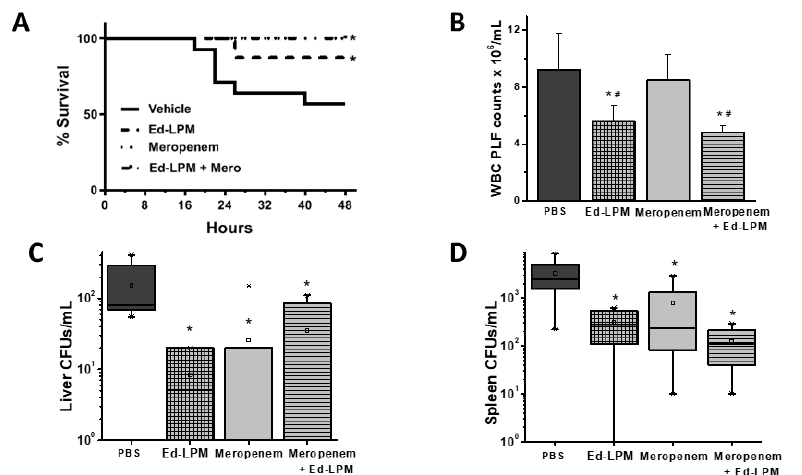
Figure 3. Effect of Ed-LPMs in antibiotic treated fecal sepsis. Mortality was significantly increased with PBS (6/14, 43%) compared to Ed-LPM therapy (1/8, 12%), Meropenem therapy (0/8, 100%), or combined Meropenem and Ed-LPM therapy (0/8, 100%) (Panel A , p = 0.021). Ed-LPM therapy—both alone and combined with Meropenem therapy—decreased peritoneal white blood cell counts (Panel B , p = 0.023); in contrast, Meropenem alone had no effect. Ed-LPM therapy, Meropenem, and the combination therapy each reduced bacterial burden in the liver (Panel C , p = 0.011) and spleen (Panel D , p < 0.001) compared with PBS-treated septic group. Note: Different batch of cecal slurry was used in this series; n = 8/group except for ED-LPM = 7; * p < 0.05 vs. Sepsis + PBS group, # p < 0.05 vs. Meropenem + PBS group’ ‘x’ in panel C is an outlier value.